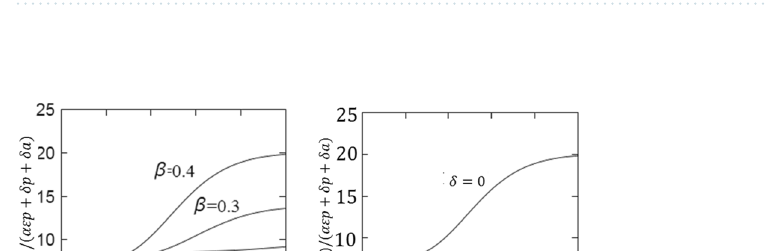
Figure 3. The time dependence of the number of infectious patients. ( a ) β = 0.4 , 0.3, 0.2 for δ = 0.0 and ( b ) δ = 0, 0.1, 0.2 for β = 0.4 .